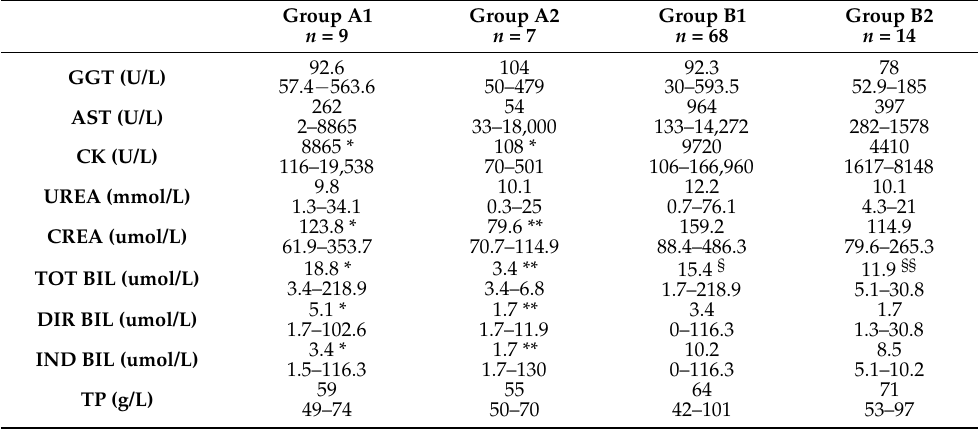
Table 5. Biochemical parameters assessed in the cohort of 98 patients categorised into